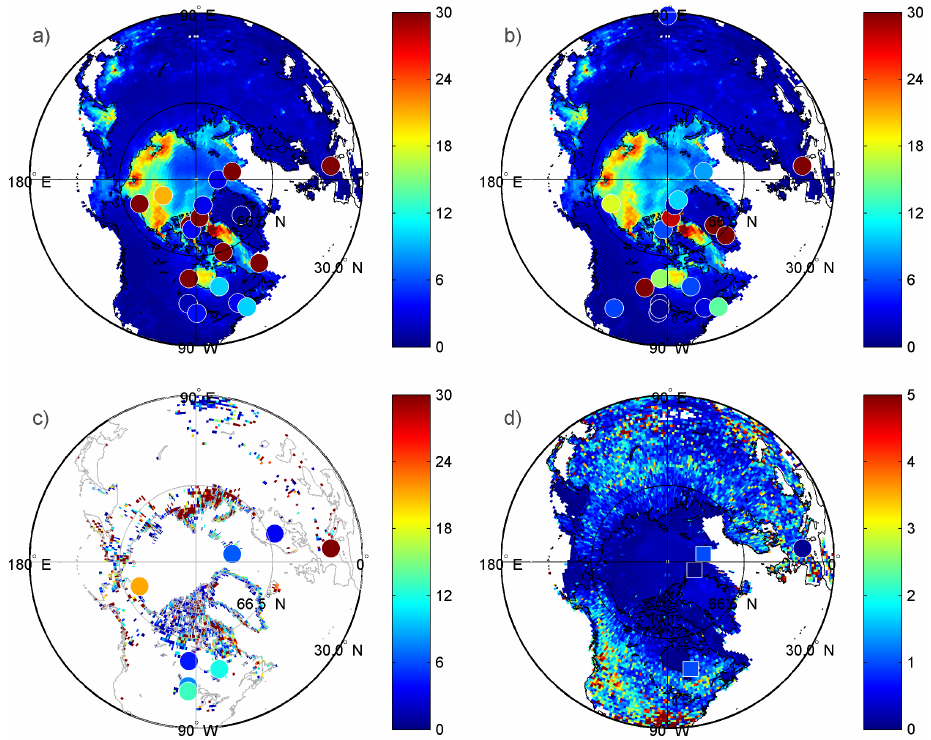
Fig. 2. Plotted, as simulated by SORun are: (a) the 5-year average (2005 to 2009) concentration (ngL − 1 ) of total mercury in the top snowpack layer, and (b) in the top and bottom snowpack layers combined; (c) the 5-yr average of each year’s maximum monthly concentration (ngL − 1 ) of total mercury in snowpack meltwater runoff; and d) the 5-yr average of the fraction (%) of total mercury in the top and bottom snowpack layers combined that is GEM. Colored circles and squares represent mean and maximum observed values,